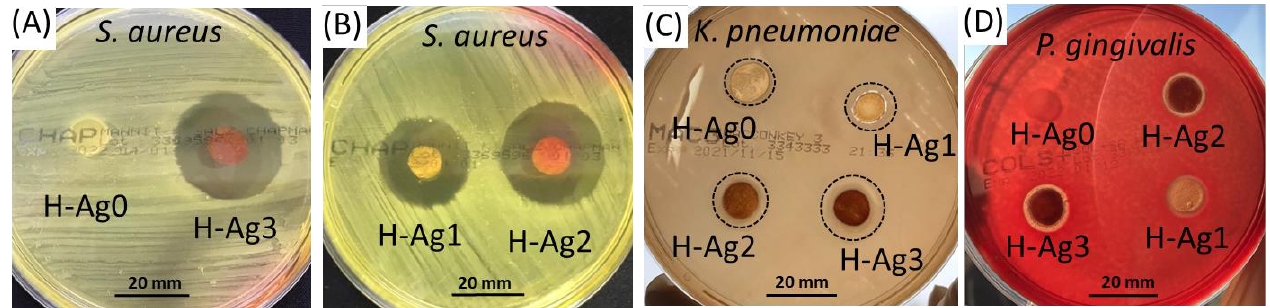
Figure 9. Antibacterial activity of composite hydrogels against S. aureus ( A,B ), K. pneumoniae ( C ), and P. gingivalis bacteria ( D ). Table 4. Diameter of inhibition zone of bacteria in the presence of nanocomposite hydrogels.